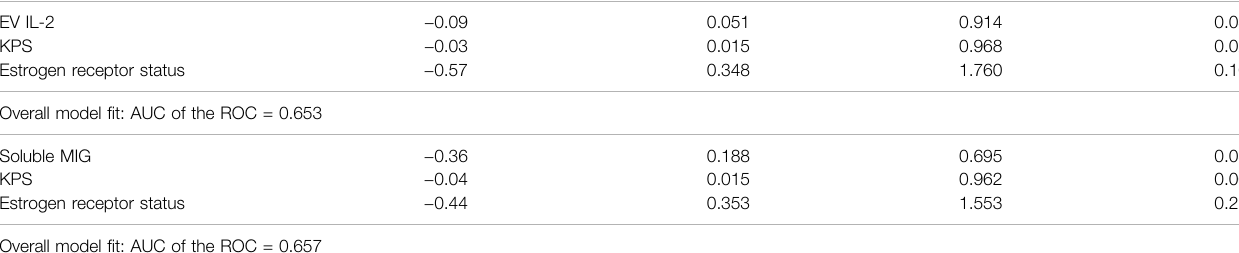
Overall model fi t: AUC of the ROC =